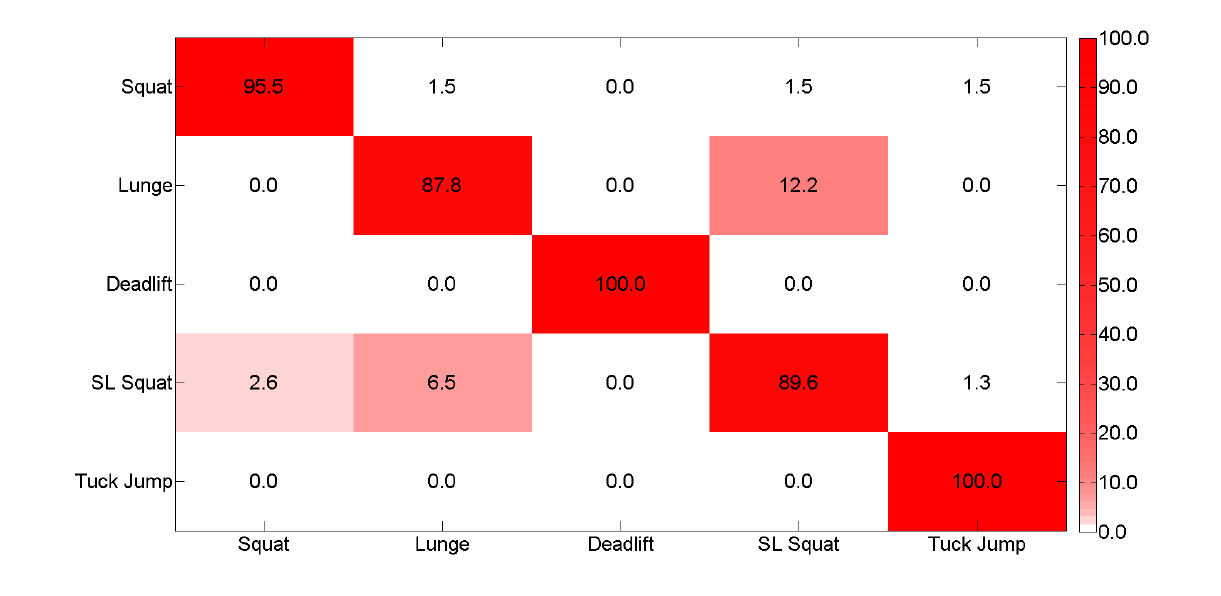
Figure 11. Confusion matrix for the feature based classification